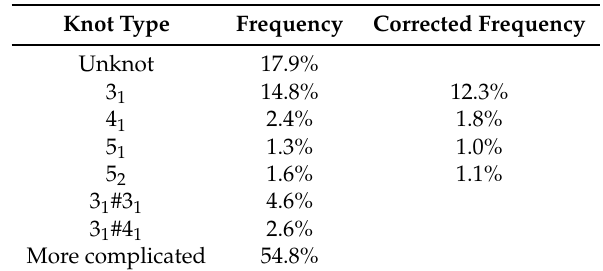
Table 1. Frequency of occurrence of the simplest and thus most common knot types found in the given structures. While the second column shows the raw output of our analysis, the third column gives the numbers after correcting for knots that are only likely to arise from the closure. All knots with termini within 20 beads of the ends of the chain are discarded. Only simple knots are shown as our detection of the knot termini is not reliable for composite